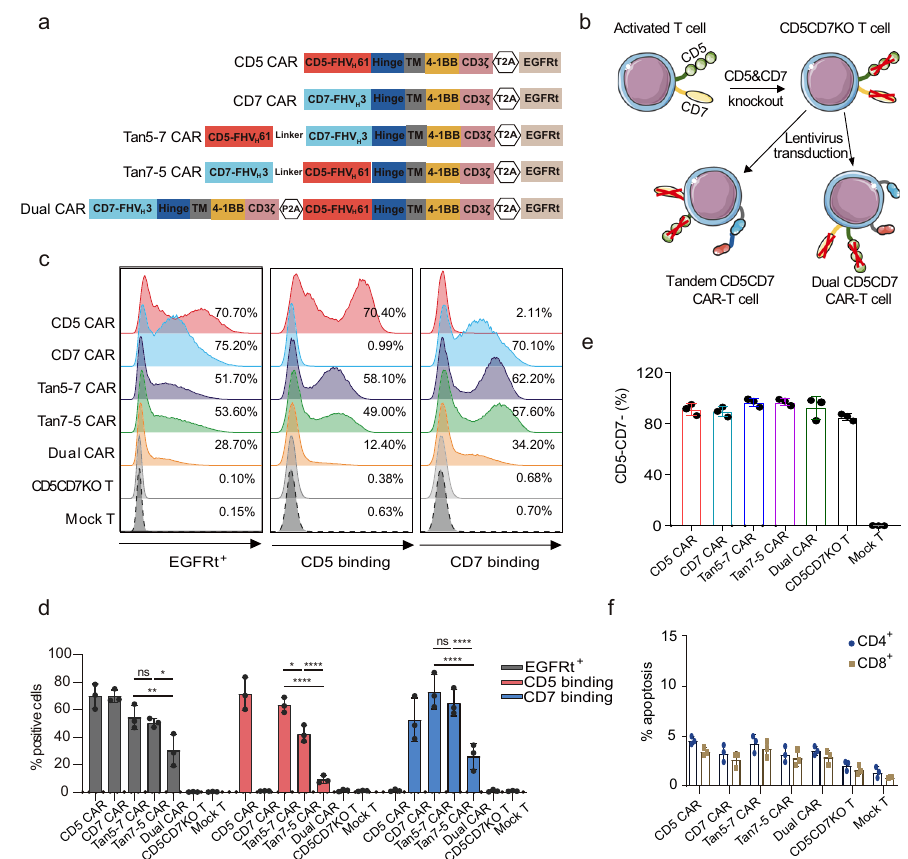
Fig. 2 CD5/CD7 bispeci fi c CARs were successfully expressed on the surface of CD5CD7KO T cells. a Schematic diagram of the fi ve CARs used in this study: CD5 CAR BBz, CD7 CAR BBz, Tan5-7 CAR BBz, Tan7-5 CAR BBz, and Dual CAR BBz. b Cartoon outline of the procedure for generating CD5CD7KO CD5/CD7 bispeci fi c CAR-T cells. This fi gure was produced using Servier Medical Art (www.servier.com). c Representative fl ow cytometry analysis showing transduction ef fi ciency of CD5CD7KO CAR-T/T and mock T cells on day 7. d Quanti fi cation and statistical analysis of the data in c . The results are displayed as mean ± SD ( n = 3), * p < 0.05, ** p < 0.01, **** p < 0.0001, ns no signi fi cance, two-way ANOVA. e Flow cytometry analysis of CD5 and CD7 expression on the surface of CD5CD7KO CAR-T/T and mock T cells on day 7. The data represents mean ± SD for three donors. f The basal apoptosis of CD5CD7KO CAR-T/T and mock T cells. The results are displayed as mean ± SD ( n =